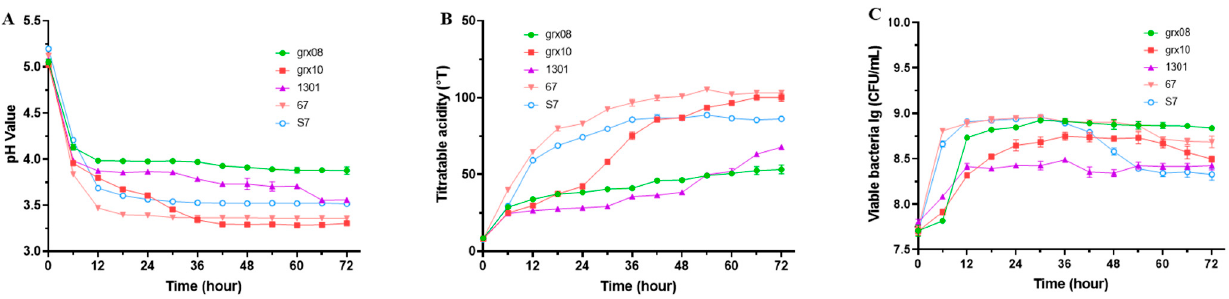
Figure 2. Changes in pH value ( A ), titratable acidity ( B ) and viable bacteria count ( C ) of SHLE fermented by different LAB. Values are expressed as the mean ± standard deviation of replicate experiments ( n = 3).